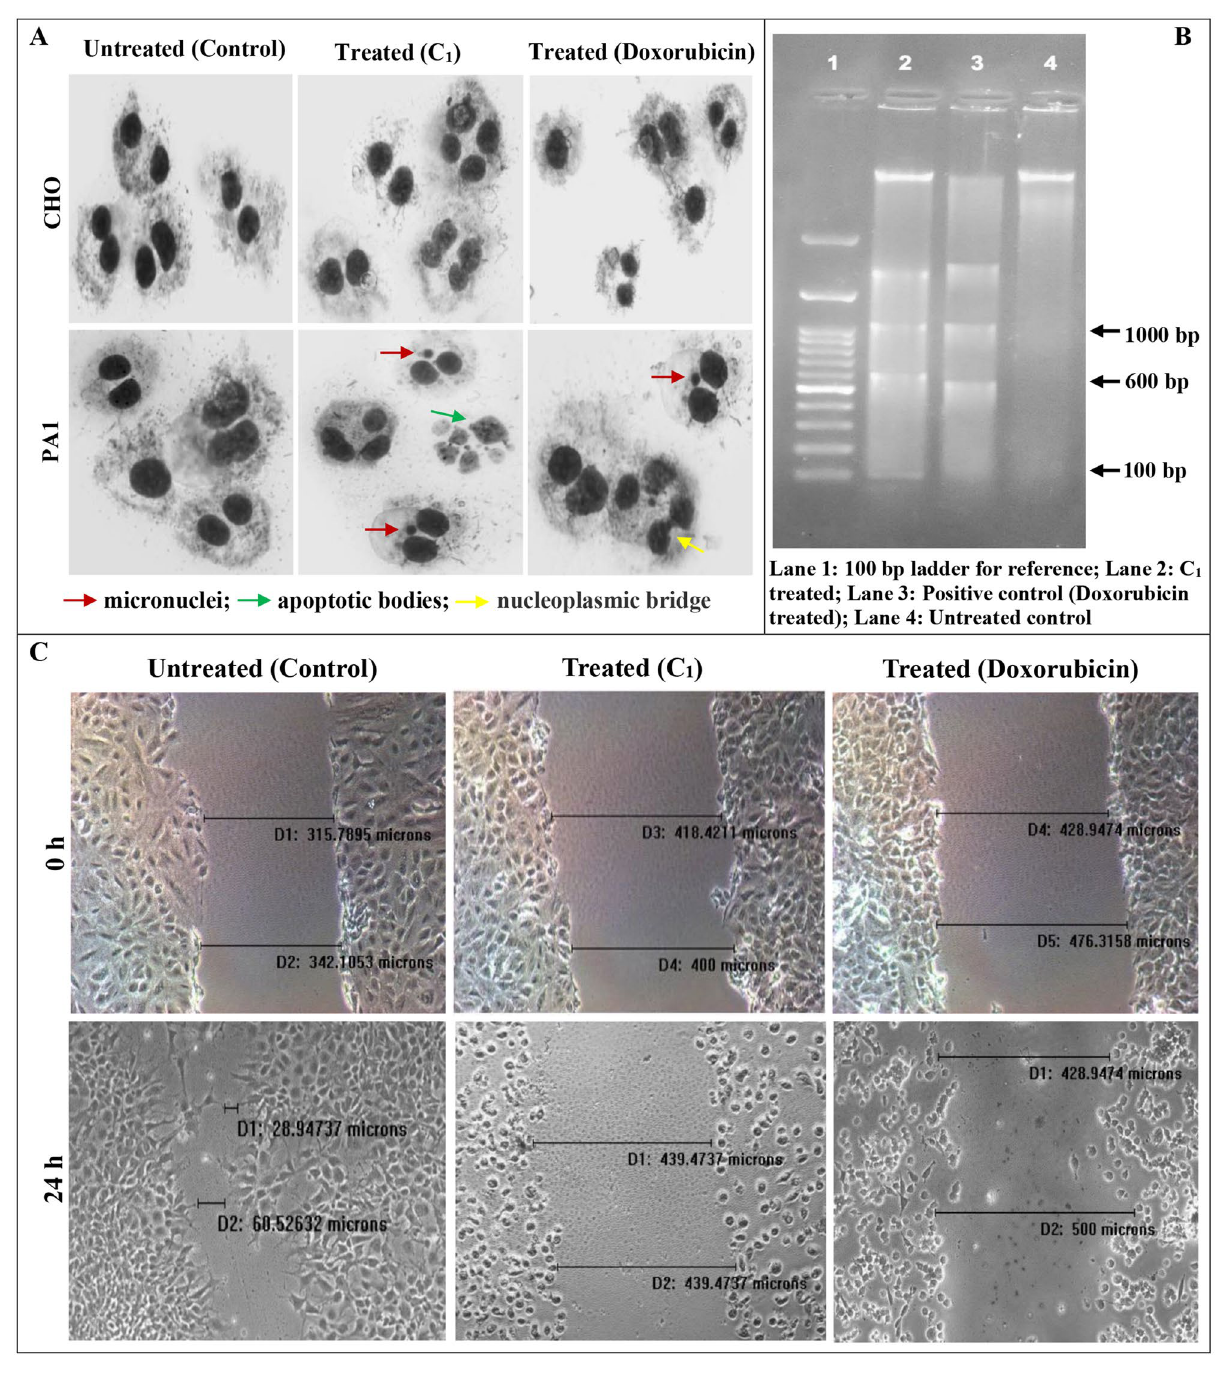
Figure 3. ( A ) clearly shows micronuclei (red arrowheads), apoptotic bodies (green arrowheads) and nucleoplasmic bridges (yellow arrowheads) for the C 1 and Doxorubicin treated cells which are not visible in untreated cells either for CHO or PA1 cell lines. Clear DNA fragmentation is seen for the cells [PA1] (treated with either C 1 /Doxorubicin) to direct apoptotic cell death ( B ). Cell migrations were clearly inhibited for C 1 / Doxorubicin treated PA1 cells [Distance migrated 7.5 and 2.4% respectively] as against their untreated controls [86.4%] ( C